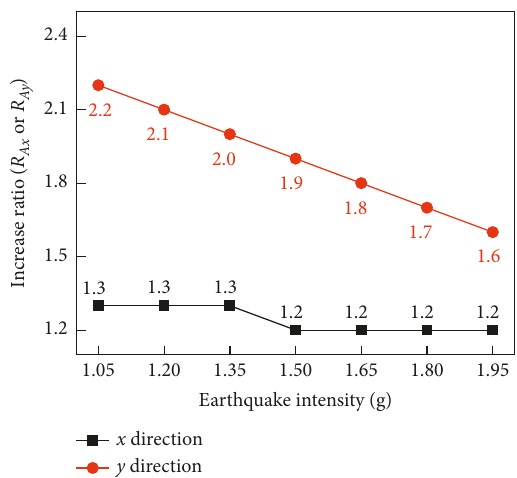
Figure 14: Comparison of acceleration increase ratio under dif- ferent earthquake excitations.